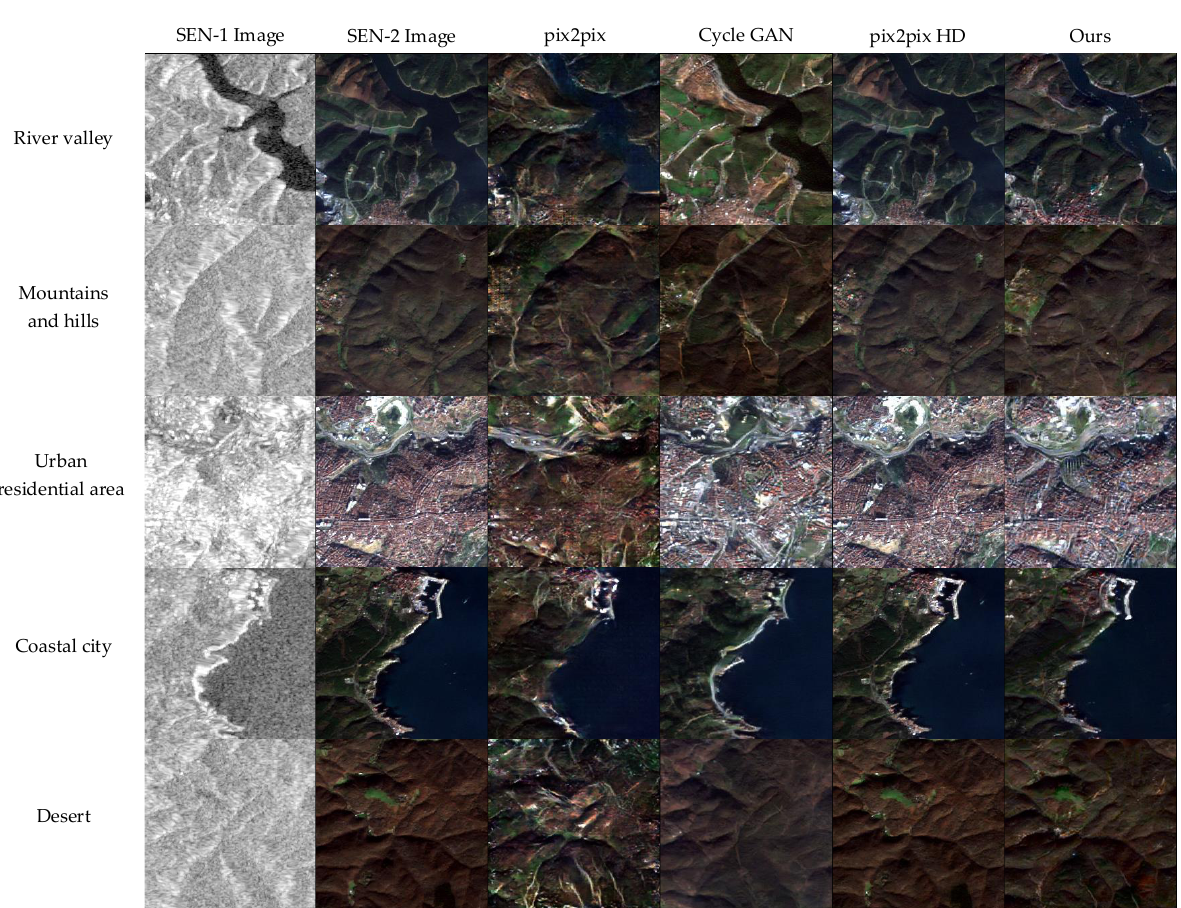
Figure 10. Comparison of the results generated by four different heterogeneous transformation models. From the top to the bottom: the remote sensing images of the river valley, mountains and hills, urban residential area, coastal city and desert. From left to right: SEN-1 images, SEN-2 images, images generated by pix2pix, images generated by CycleGAN, images generated by pix2pixHD, and the images generated by our model.